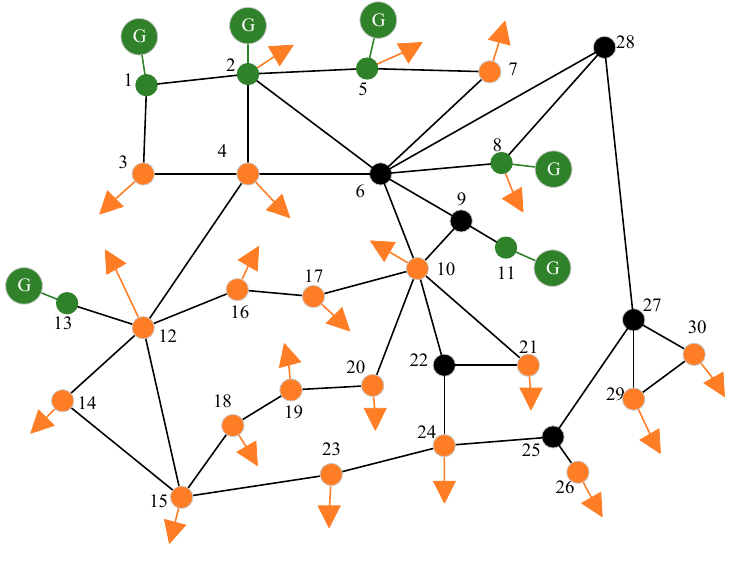
Figure 11. IEEE 30-bus test system.